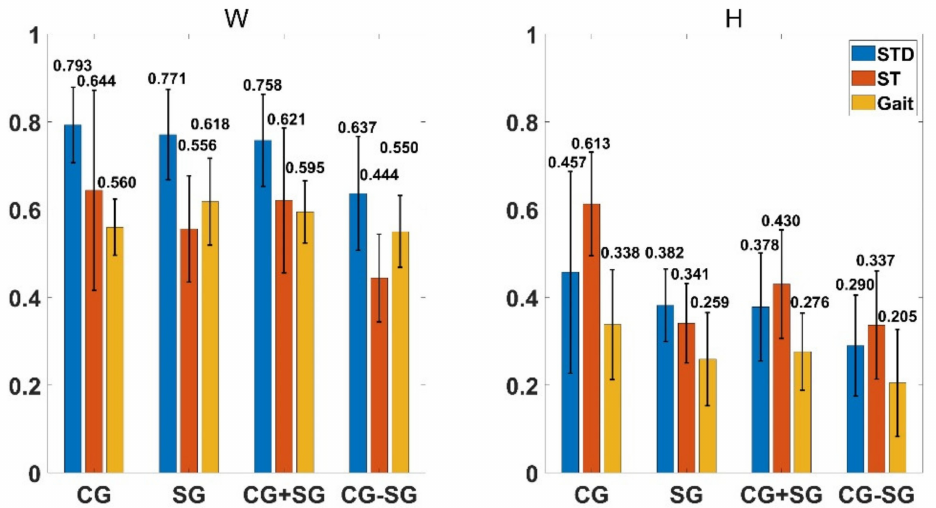
Figure 6. Intra-similarity of different subject groups (CG, SG and the combined group CG + SG) and the inter-similarity between CG group and SG group (CG-SG) when performing three differ- ent motions (STD, ST and Gait). The numbers on the bar represent the corresponding average similarity coefficient.